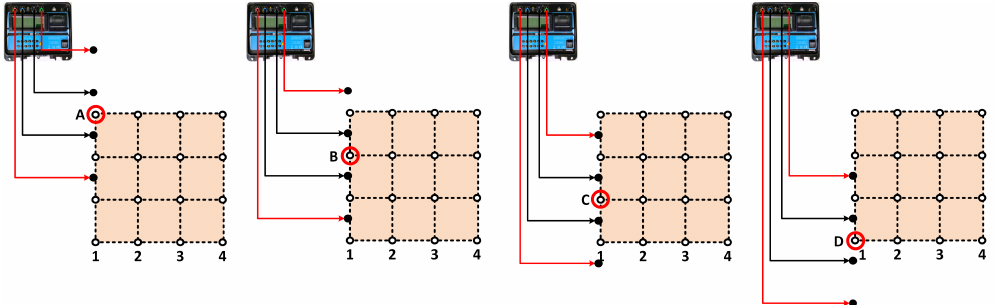
Figure 2. Lateral Profiling